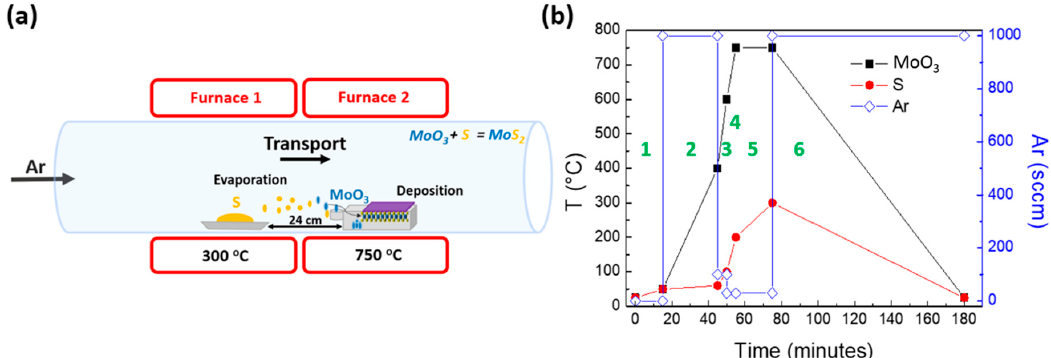
Figure 1. ( a ) Pictorial of the two-furnace chemical vapor deposition (CVD) apparatus for the growth of molybdenum disulfide (MoS 2 ). ( b ) Furnace temperature profile as a function of process time (molybdenum trioxide (MoO 3 ), black line; Sulphur (S), red line; left vertical axis) and argon (Ar) flux (blue line; right vertical axis) during the six steps of the growth process.